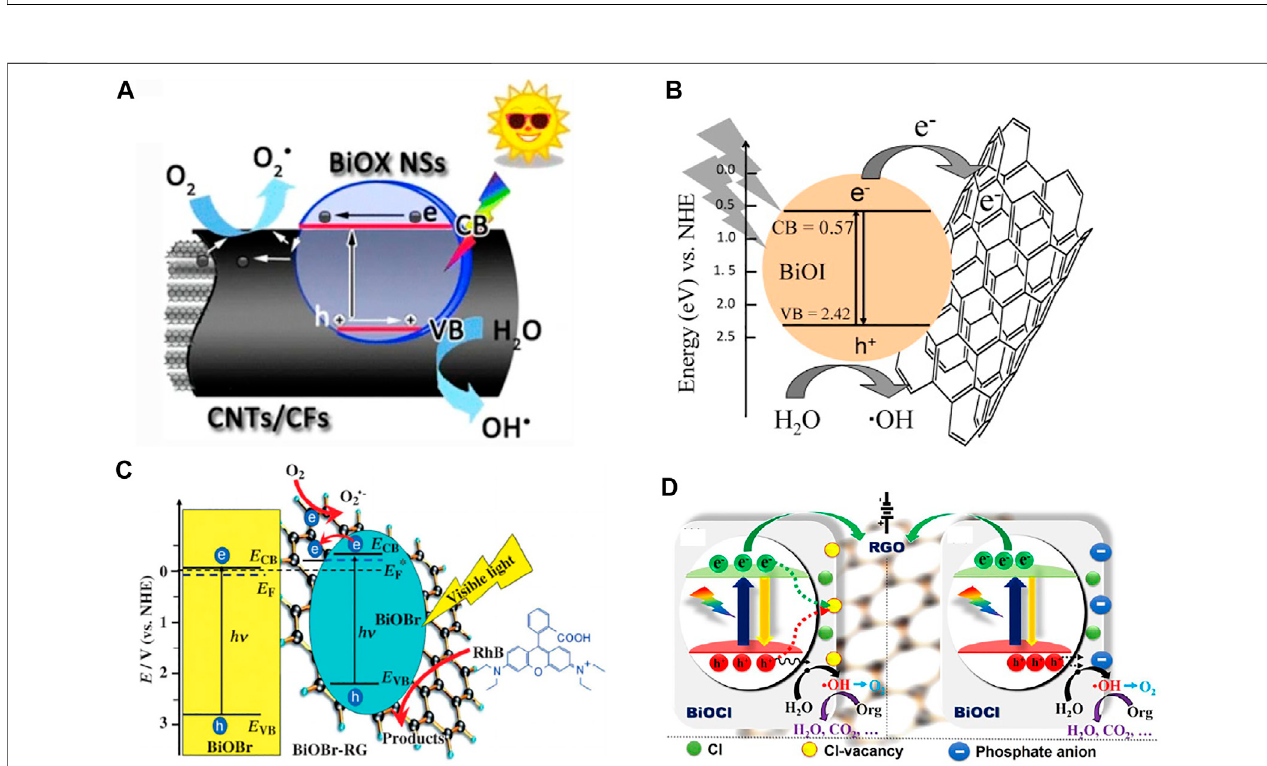
FIGURE 9 | (A) Mechanism of photocatalytic reaction over BiOX/CNT (Weng et al., 2014b). (B) Electron transfer between BiOI and MWCNT (Su et al., 2012). (C) Photodegradation over BiOBr/graphene (Tu et al., 2012). (D) Charge transfer ofRGO/BiOCl photoanodes before and after phosphate modi fi cation (Li Z.et al., 2017) (all reproduced with